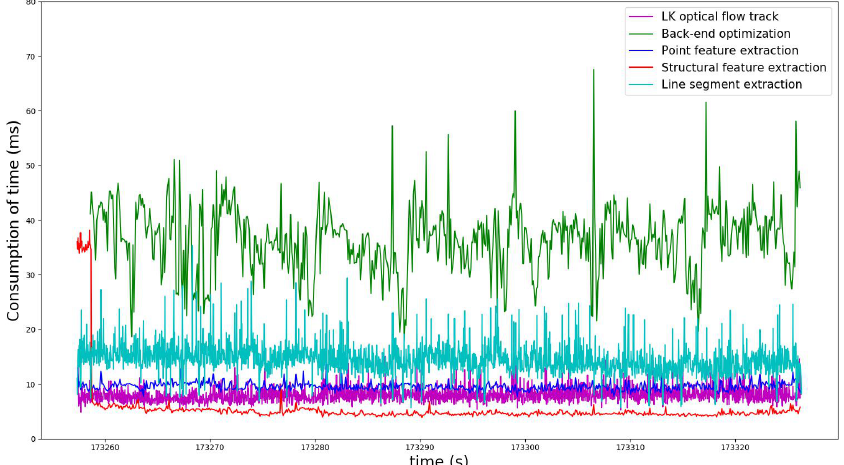
Figure 14. The time consumption of each main module in the mobile